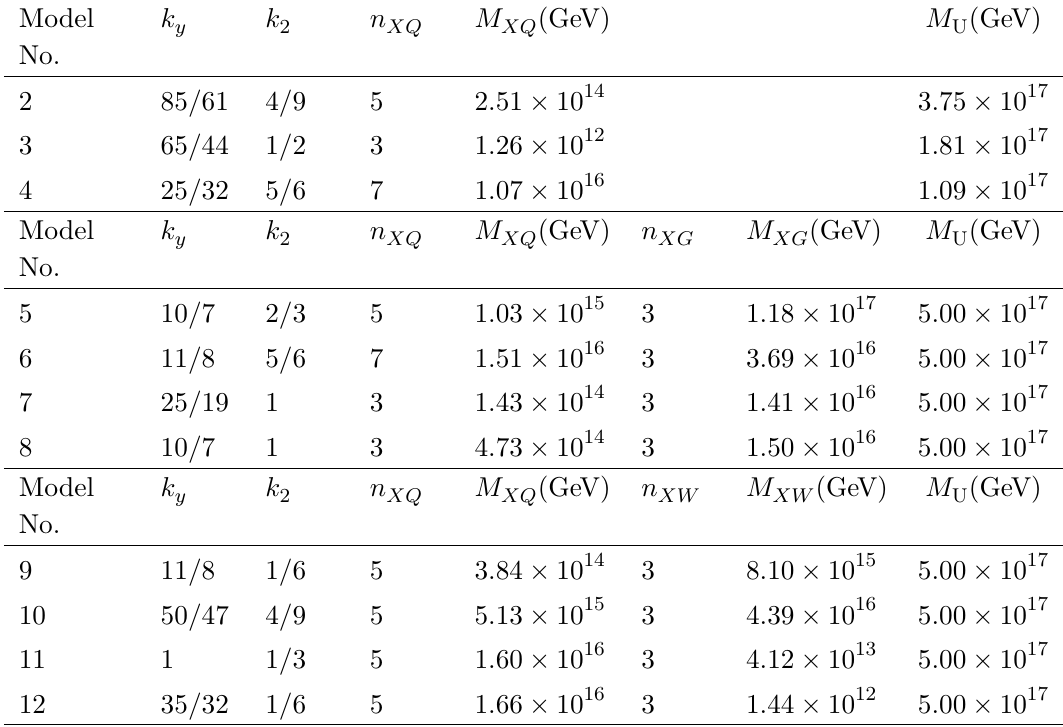
Table 4 . String-scale gauge coupling relations achieved by adding vector-like particles XQ + XQ as well as XG or XW , from N = 2 subsector. The number of vector-like particles are defined by the intersection number on a and b stacks, n